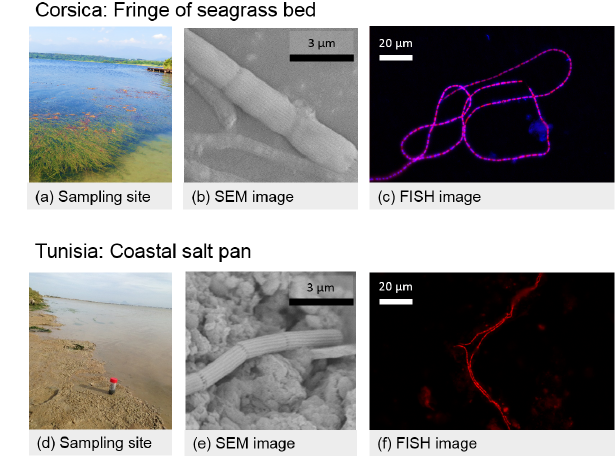
Figure 7. Microscopy reveals the presence of cable bacteria in two different habitats in the Mediterranean. (a–c) Sediment near a sea- grass bed in the Urbino lagoon (Corsica, France). (d–f) Sediment near the water line of the salt pan Sabkhet Arina (Tunis, Tunisia). Left image: photograph from the sampling sites. Middle image: scanning electron micrographs of cable bacteria filaments with the typical ridge pattern. Right image: Fluorescence in situ hybridiza- tion (FISH) images using a DSB706 probe. Full-size SEM images are available in the Supplement (Fig.